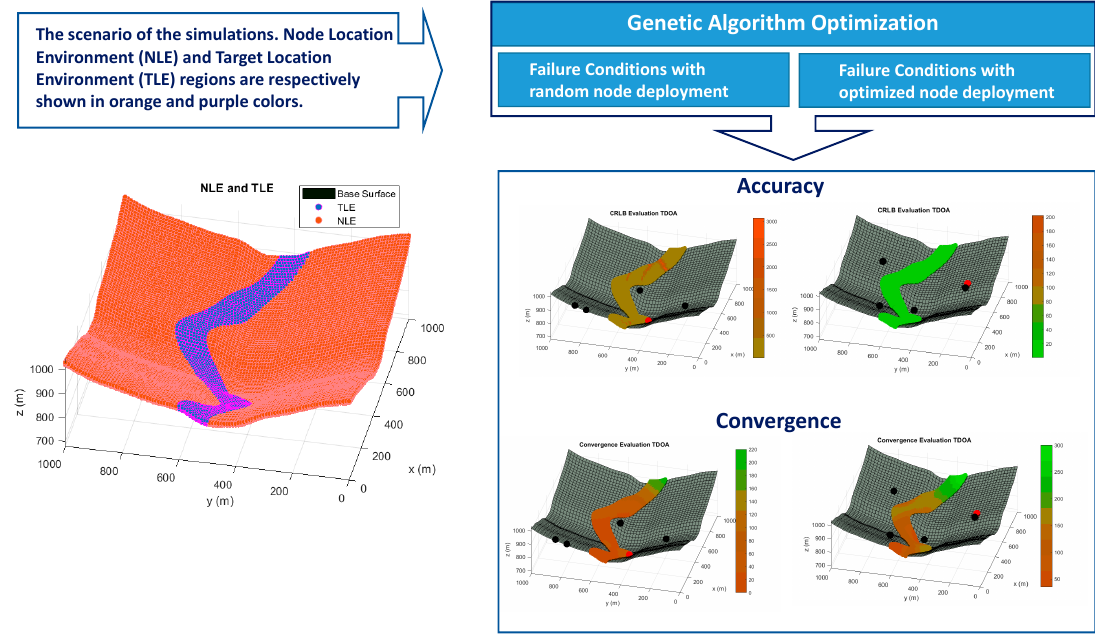
Figure 1. Graphical